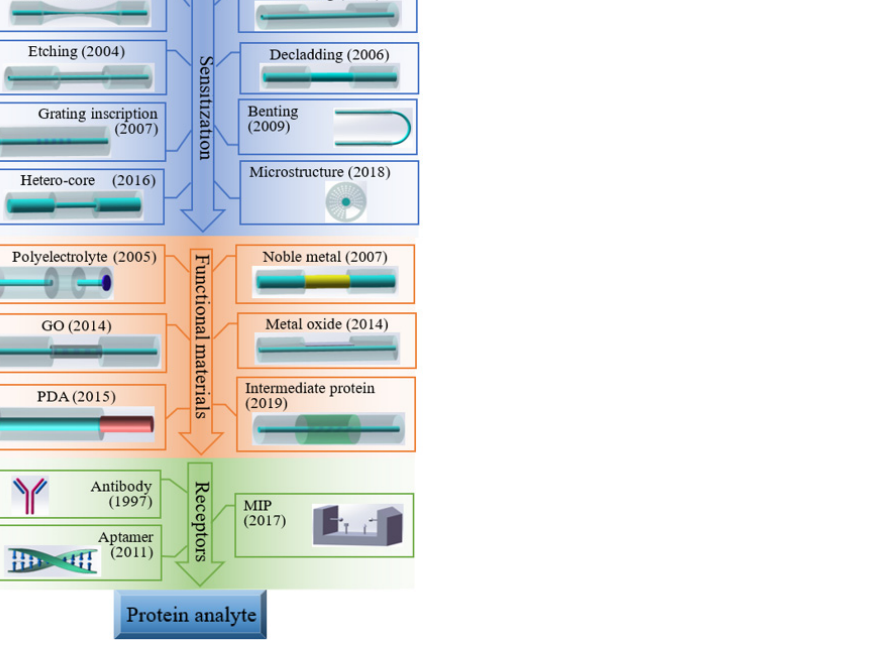
Figure 1. Schematic diagram of the fabrication of optical fiber biosensors for protein de- tection.